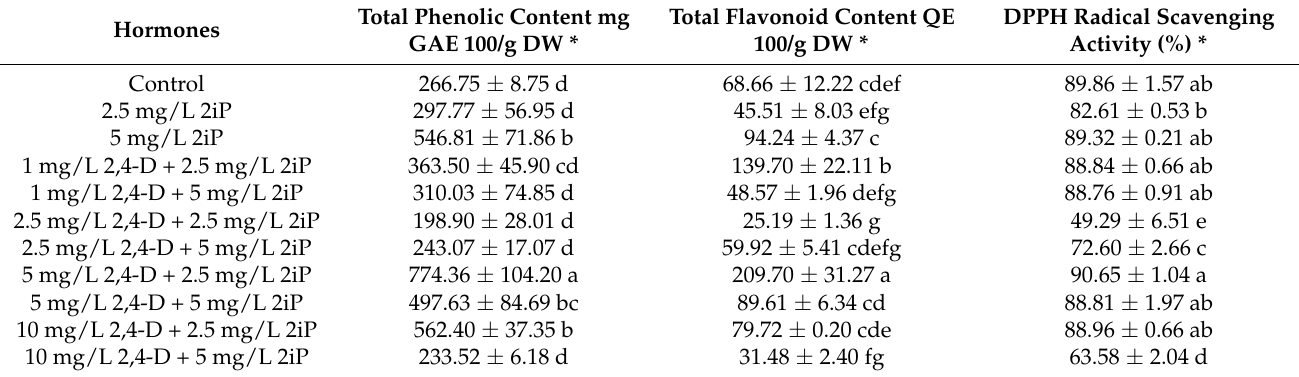
Table 1. Effect of 2iP and 2,4-D on total phenolic content (TPC), total flavonoid content (TFC) accumulation and RSA (%) in cell suspension of date palm at the eleventh week of